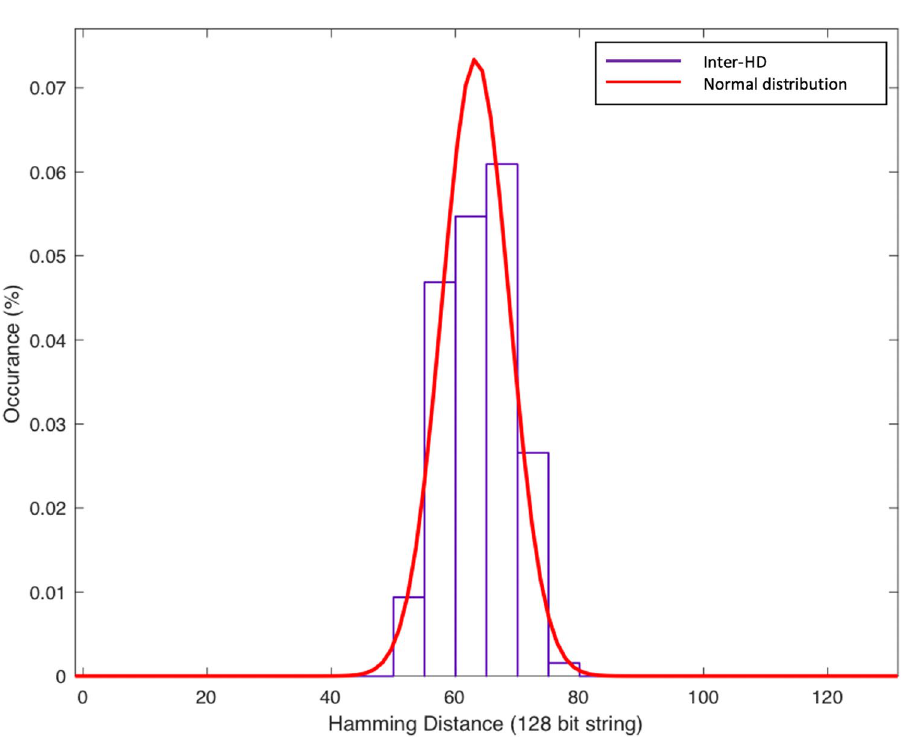
Figure 10. Hamming distance distribution for evaluating uniqueness: mean of HD is 63.2 which is 49.3% which is almost 50% the ideal